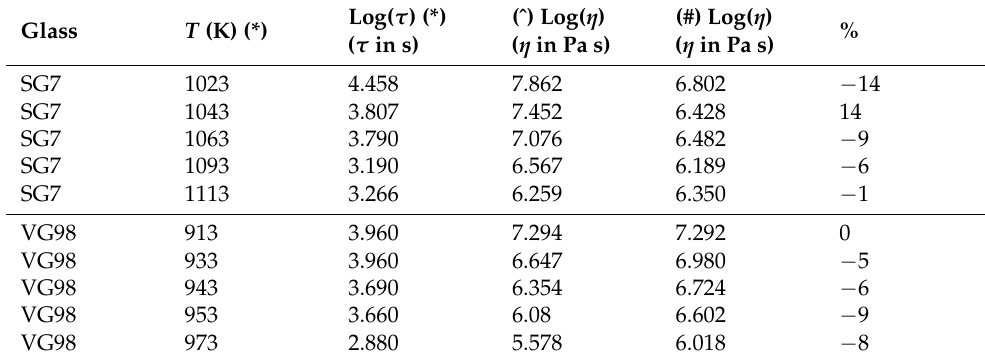
Table 2. (#) Assigned using Equation (10). (%) Percentage difference between # and